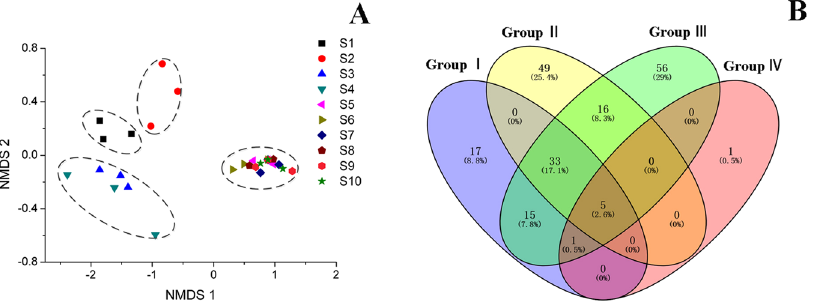
Figure 2. NMDS ( A ) and Venn diagram analysis ( B ) of fungal communities in samples during manufacturing process of Fu brick